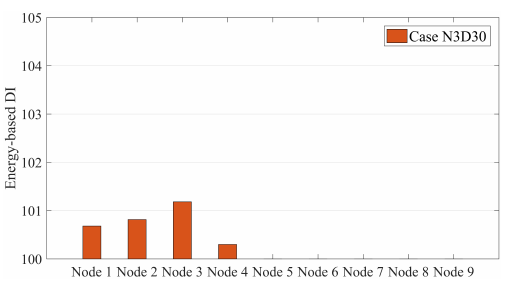
Figure 8. Energy-based damage indices (DIs) along a simply supported beam subjected to moving sprung mass with a speed of 2.5 m/s for case N 3 D 30.